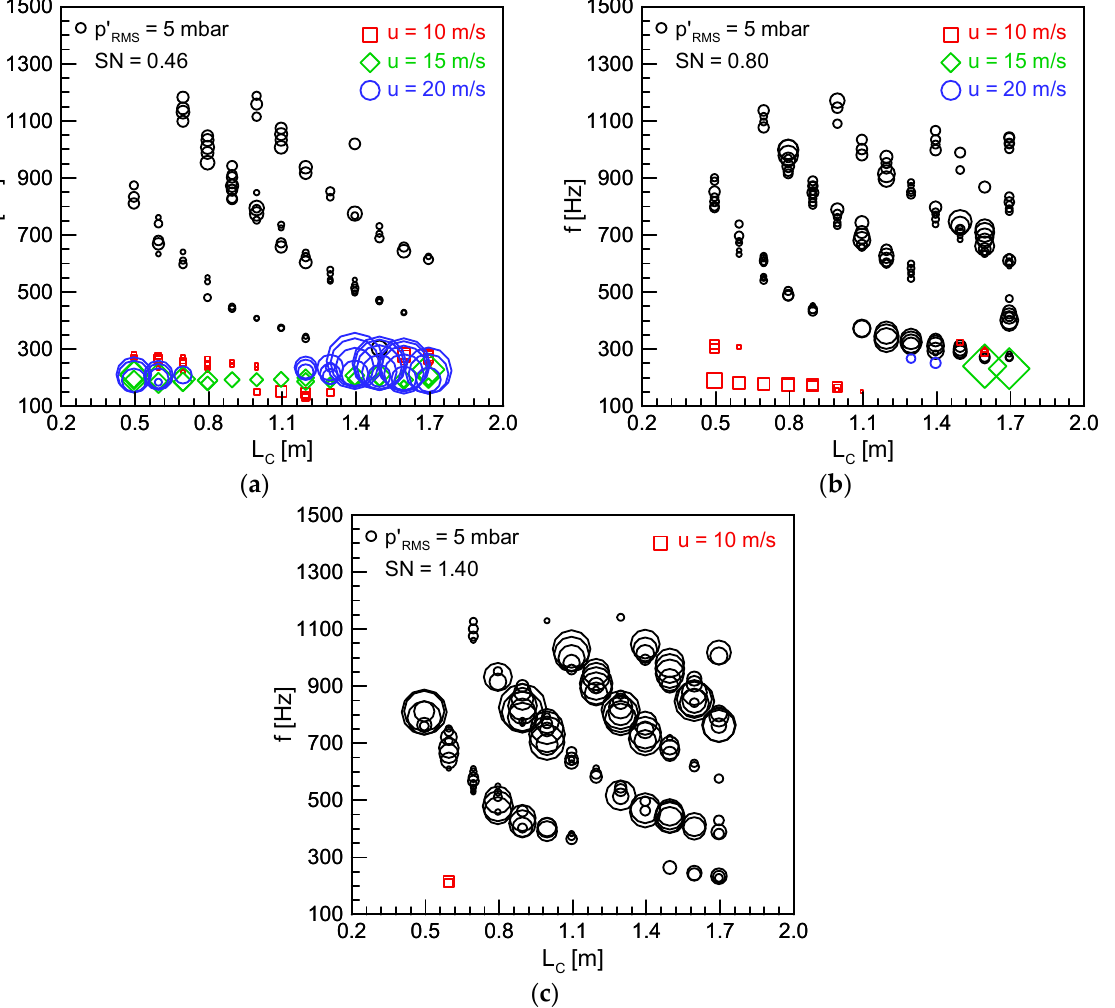
Figure 4. Dominant frequencies and their RMS values as a function of combustion chamber length using C 2 H 4 : ( a ) SN = 0.46, ( b ) SN = 0.80, and ( c ) SN =